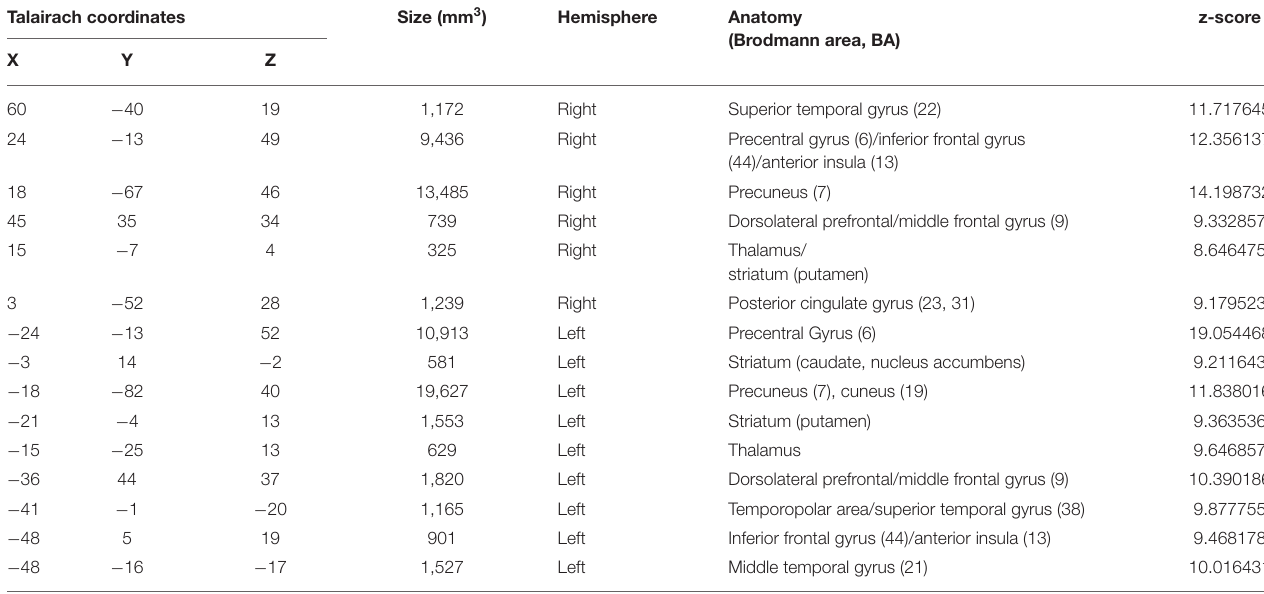
TABLE 1 | Brain areas with significant activation, considering the 3-factor ANOVA analysis (FDR corrected q < 0.05), during neurofeedback runs. Talairach